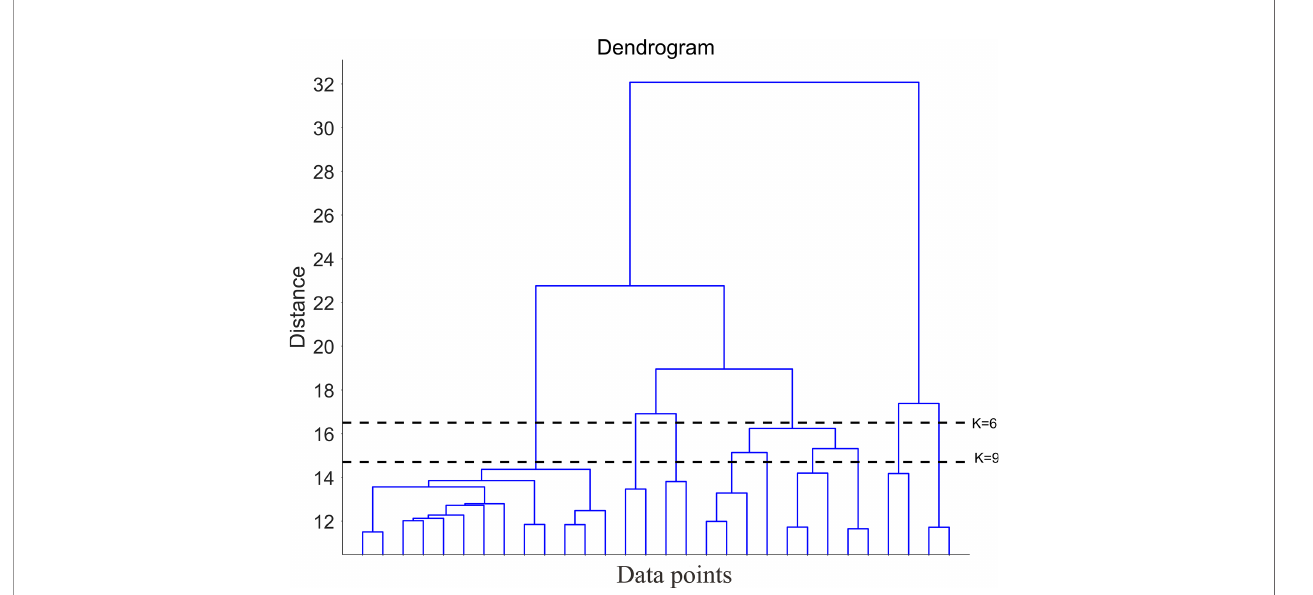
FIGURE 3 | Dendrogram obtained from hierarchical clustering. The dotted lines ( K =6 and K =9) show the levels at which the dendrogram was cut to produce the